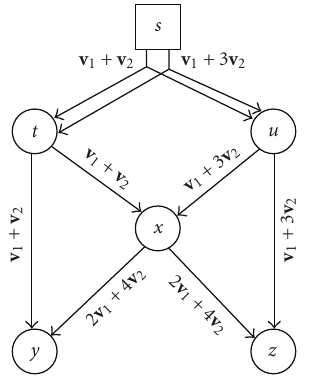
Figure 3: The source node s transforms the packets v 1 and v 2 by T S , and sends the outputs u 1 = v 1 + v 2 and u 2 = v 1 + 3 v 2 to sink nodes y and z